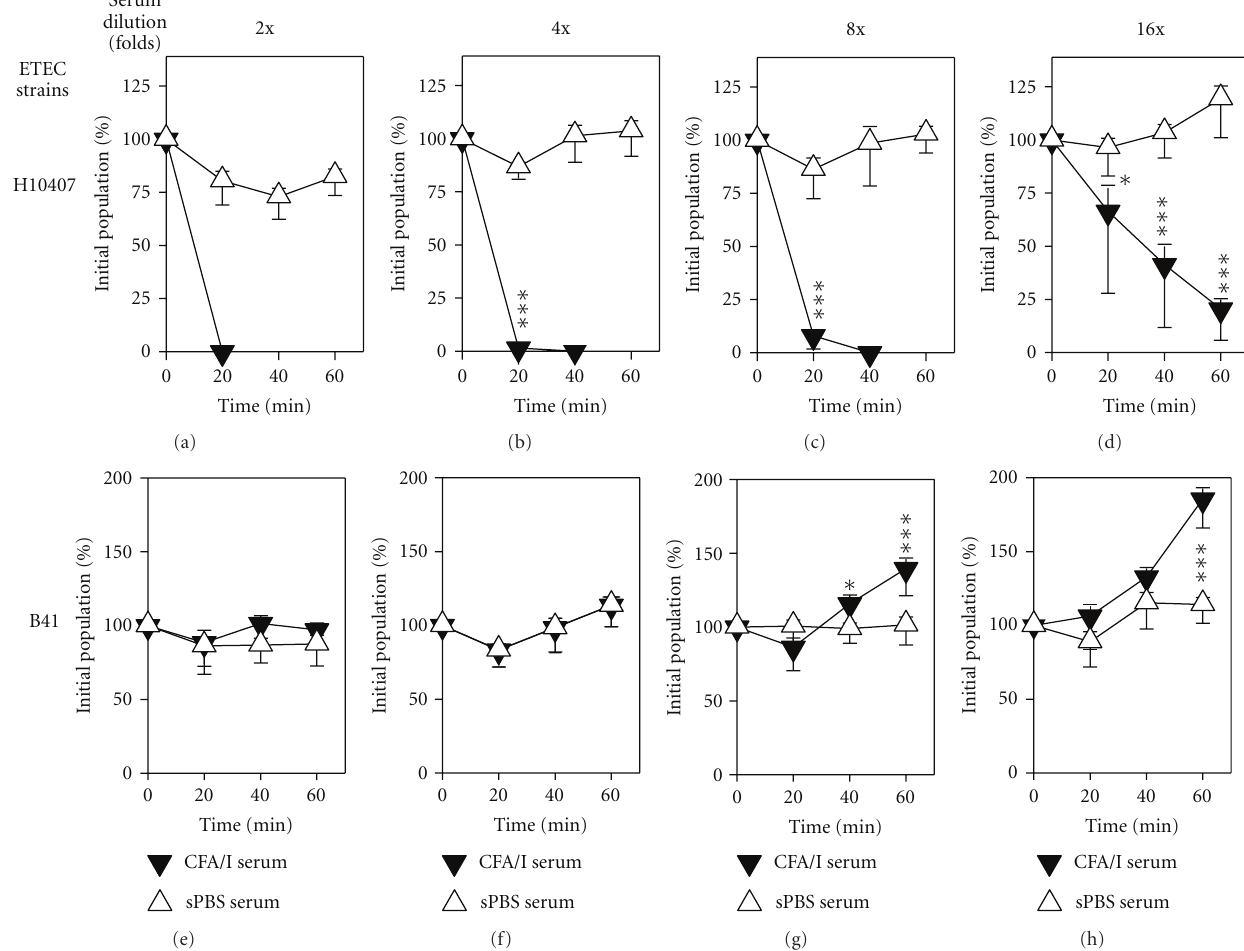
Figure 5: The sera from the CFA/I-immunized mice are e ff ective in killing wt CFA/I + ETEC H10407 but not K99 + ETEC B41. The sera of the 60 µ g CFA/I-immunized mice were compared to those from sPBS-dosed mice (Figure 1) for bactericidal activity serially diluted (a, e) 2-, (b, f) 4-, (c, g) 8-, and (d, h) 16-fold. Depicted are the percentages of the survival bacterial CFU relevant to the initial bacterial CFU before supplement of sera (time = 0min). At 20, 40, and 60 min after incubation, the bacterial survival rates were statistically calculated between anti-CFA/I sera and the -sPBS sera via Student’s t -test: ∗ P < 0 . 05, ∗∗ P < 0 . 01, and ∗∗∗ P < 0 . 001. Values are the mean ± SEM ( n =